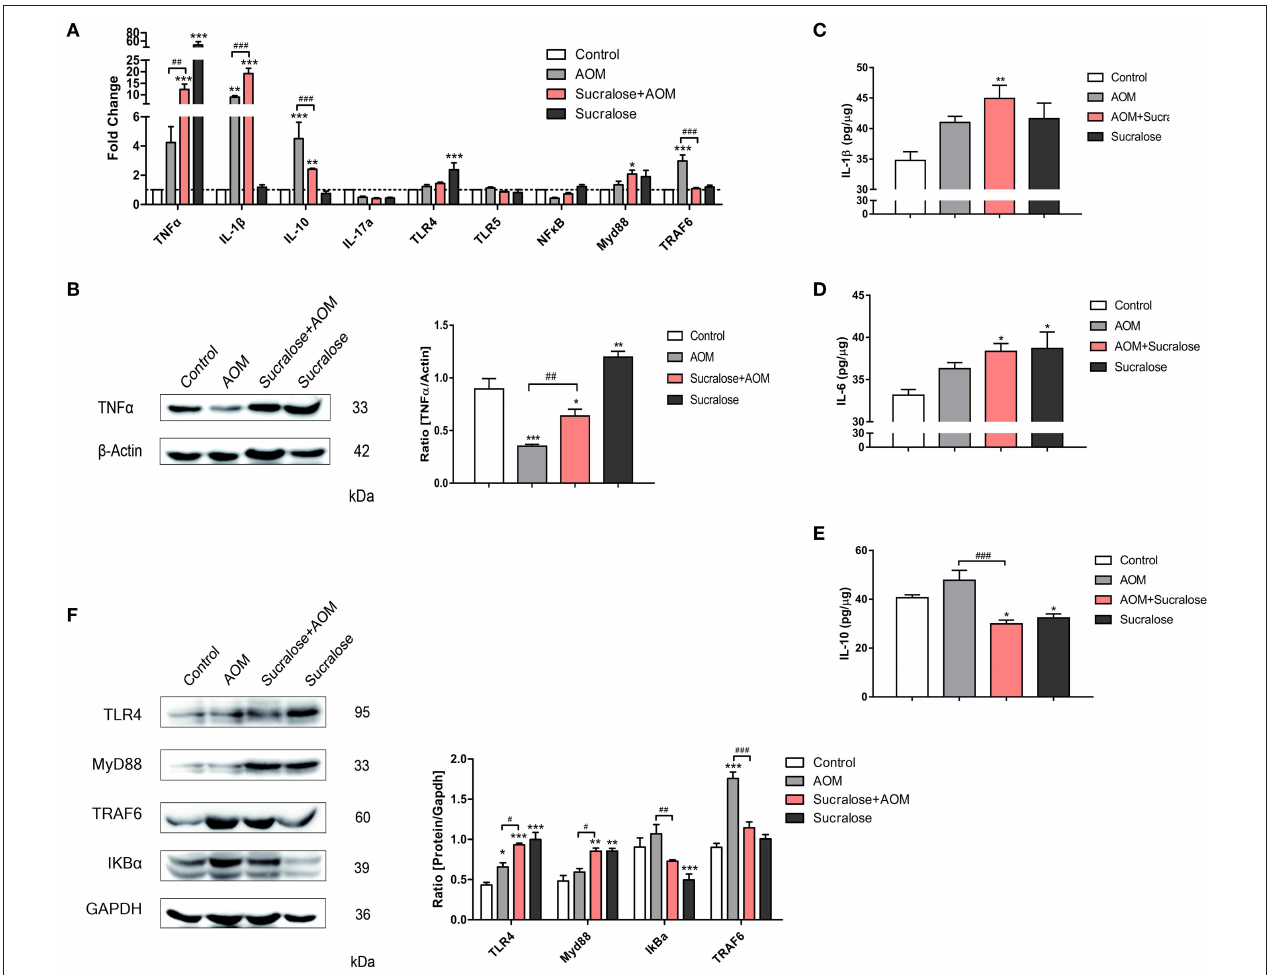
FIGURE 5 | Sucralose promotes expression of pro-inflammatory factors. (A) Changes in mRNA levels of cytokines and TLR4/MyD88/TRAF6/NF- κ B signaling pathways ( n = 8). (B) Protein expression of TNF α . (C) Proteins of IL-1 β in colon tissues. (D) Protein levels of IL-6 in colon tissue. (E) Protein levels of IL-10 in colon tissues. (F) Changes in protein levels of TLR4/MyD88/TRAF6/NF- κ B signaling pathways. Compared with the control group: * P < 0.05, ** P < 0.01, *** P < 0.001; compared with the AOM group: # P < 0.05, ## P < 0.01, ### P < 0.001, n =